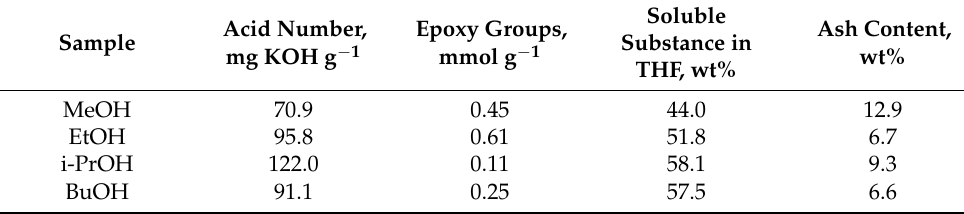
Table 4. Chemical properties of SA-based adhesive